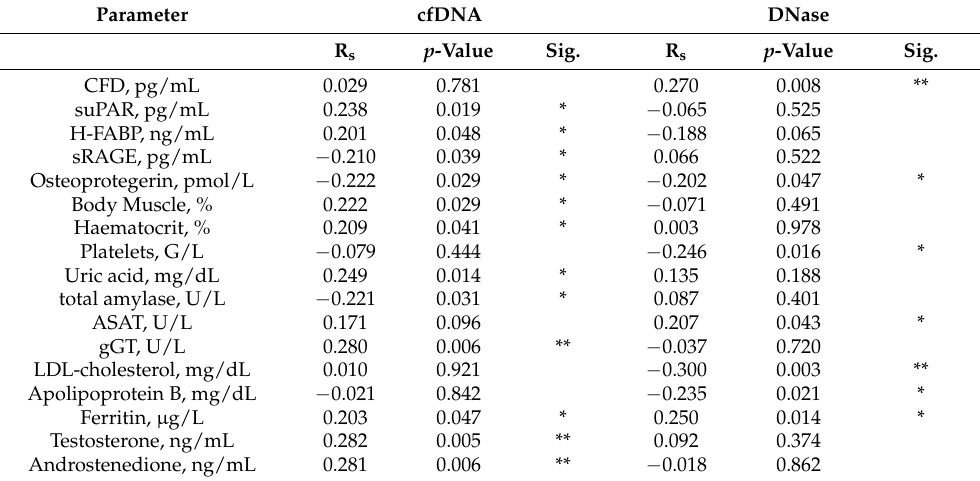
Figure A1. Breakdown of the number of cardiovascular risk factors (CV-RF) per participant. Table A1. Correlations of clinical parameters with cfDNA and DNase